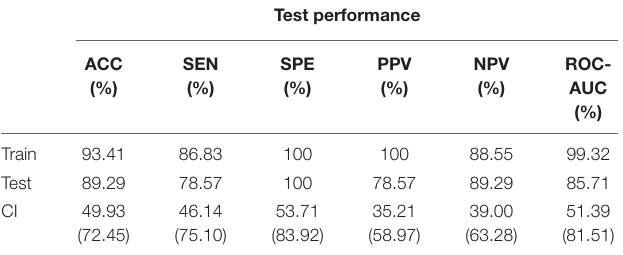
TABLE 5 | Performance report of the random forest classifier.